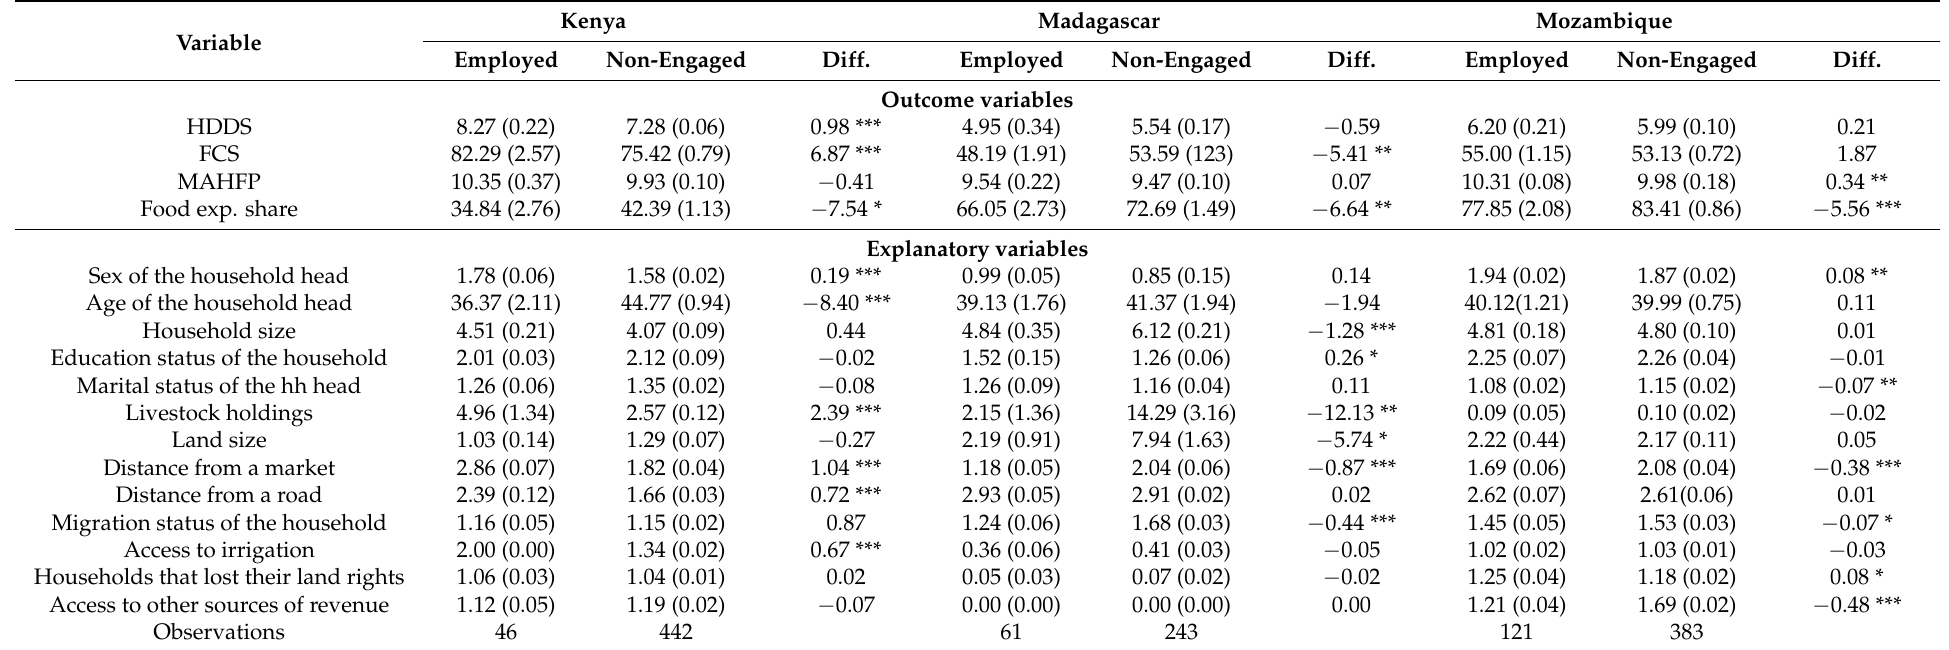
Table 6. Descriptive statistics of the